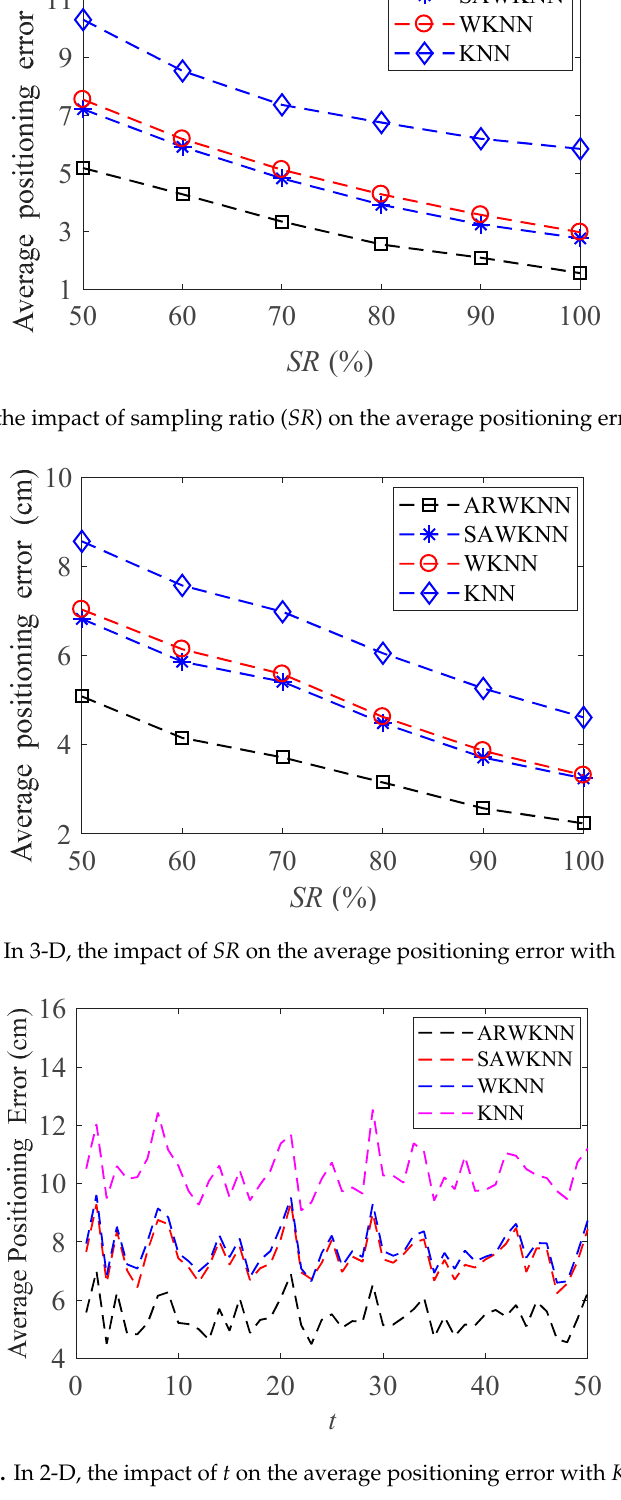
Figure 18. In 2-D, the impact of t on the average positioning error with K max = 4.